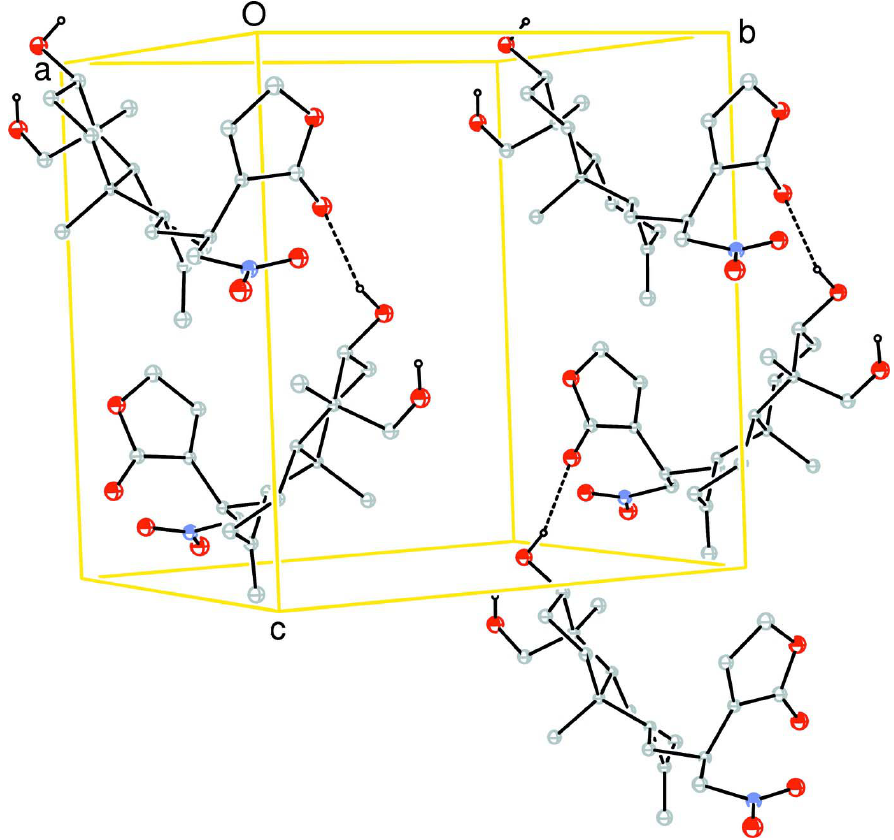
Figure 2 A partial packing diagram of (I). Hydrogen bonds are shown as dashed lines. H atoms not involved in hydrogen bonding have been omitted for